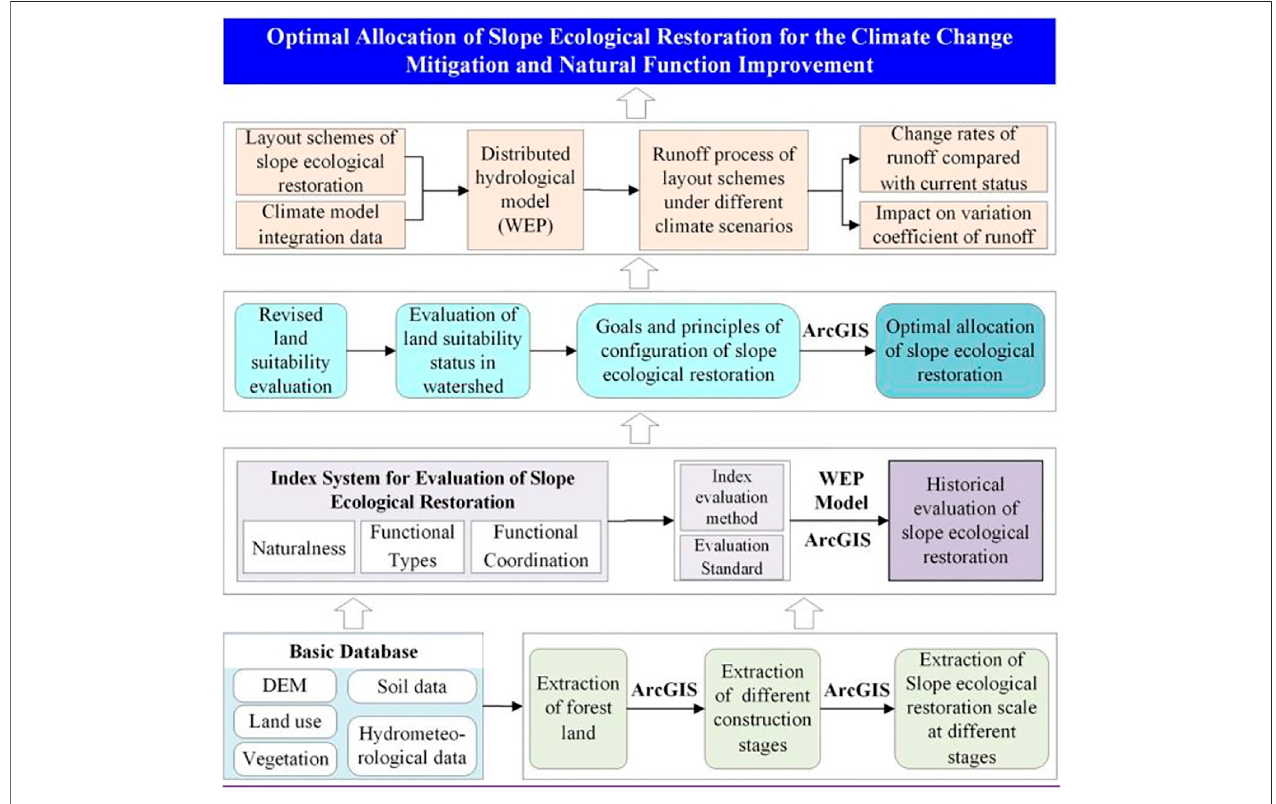
FIGURE 2 | Work fl ow for the optimal allocation of slope ecological restoration for the climate change mitigation and natural function improvement.